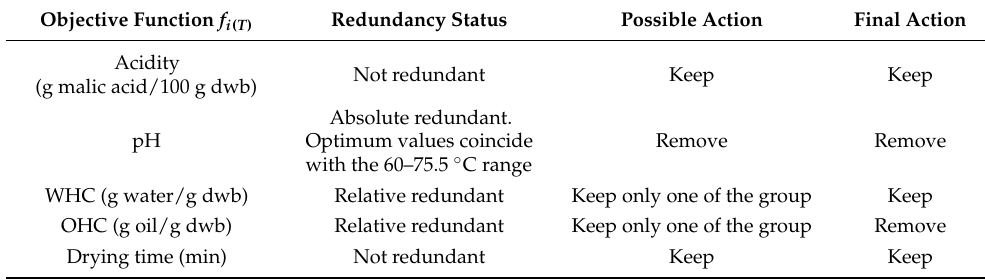
Table 2. Summary of the selection